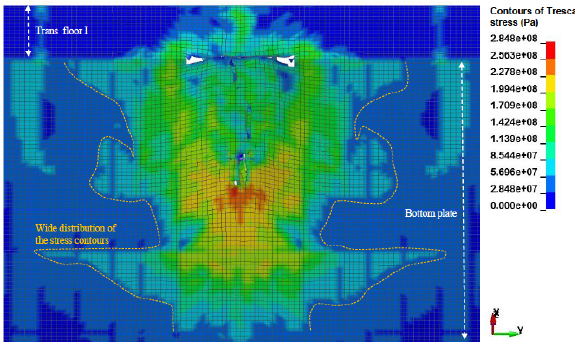
Overall results of the acceleration shared same ten- dency with the internal energy criterion (Figure 16), which